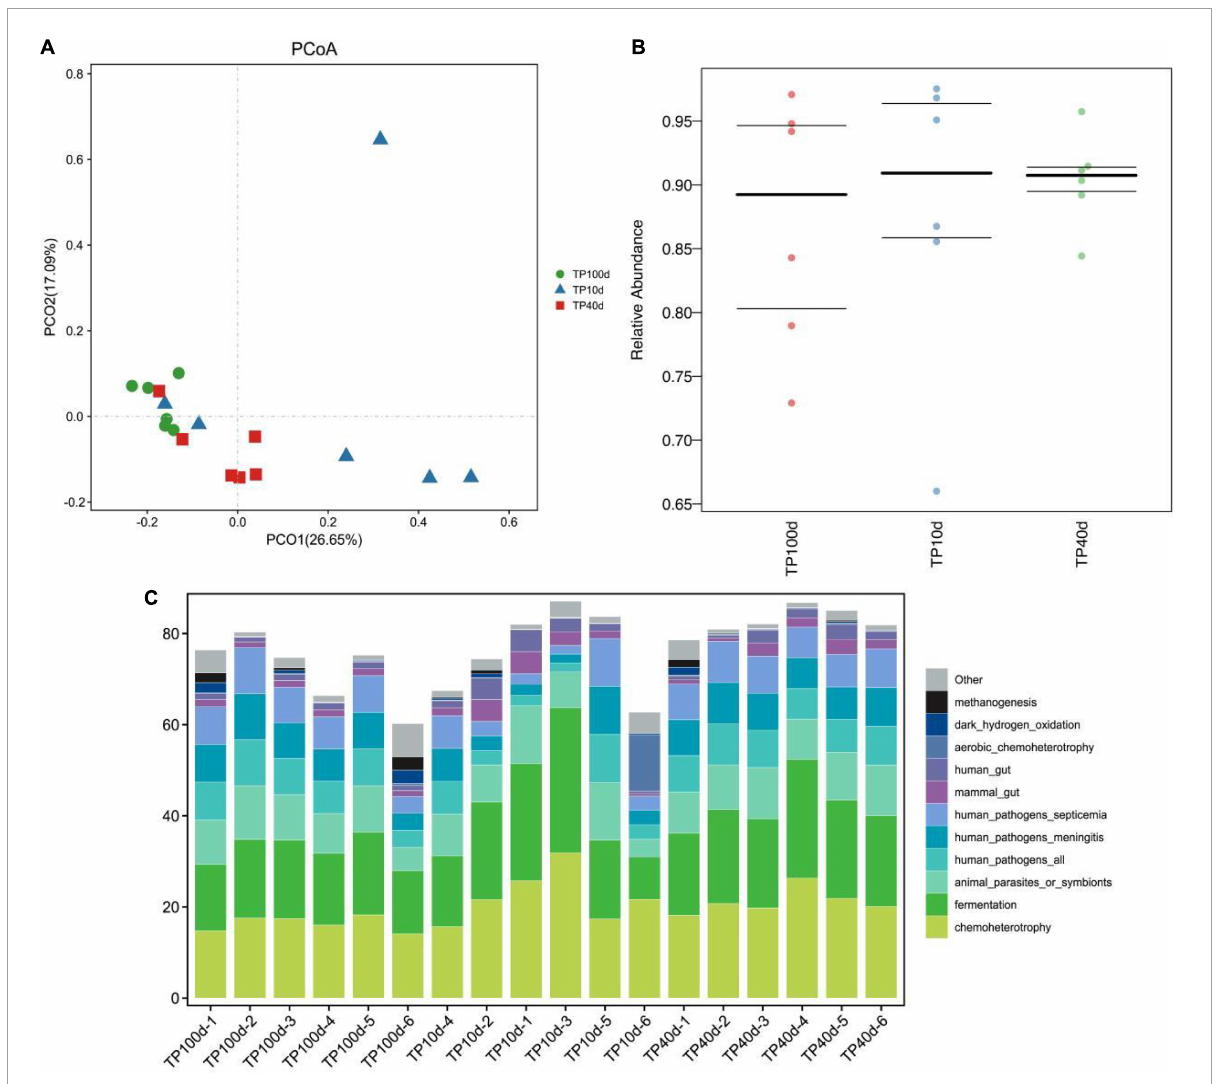
FIGURE6 Prediction of intestinal microbial ecological function of Tibetan pig at different growth stages. (A,B) PCoA analysis of group TP10d, TP40d, and group TP100d at the genus level. Each point represents a sample. The distance between the two points indicates the difference in fecal microbiota. (CmurF) TP10d, TP40d, and TP100d intestinal microbial ecological function prediction (C)